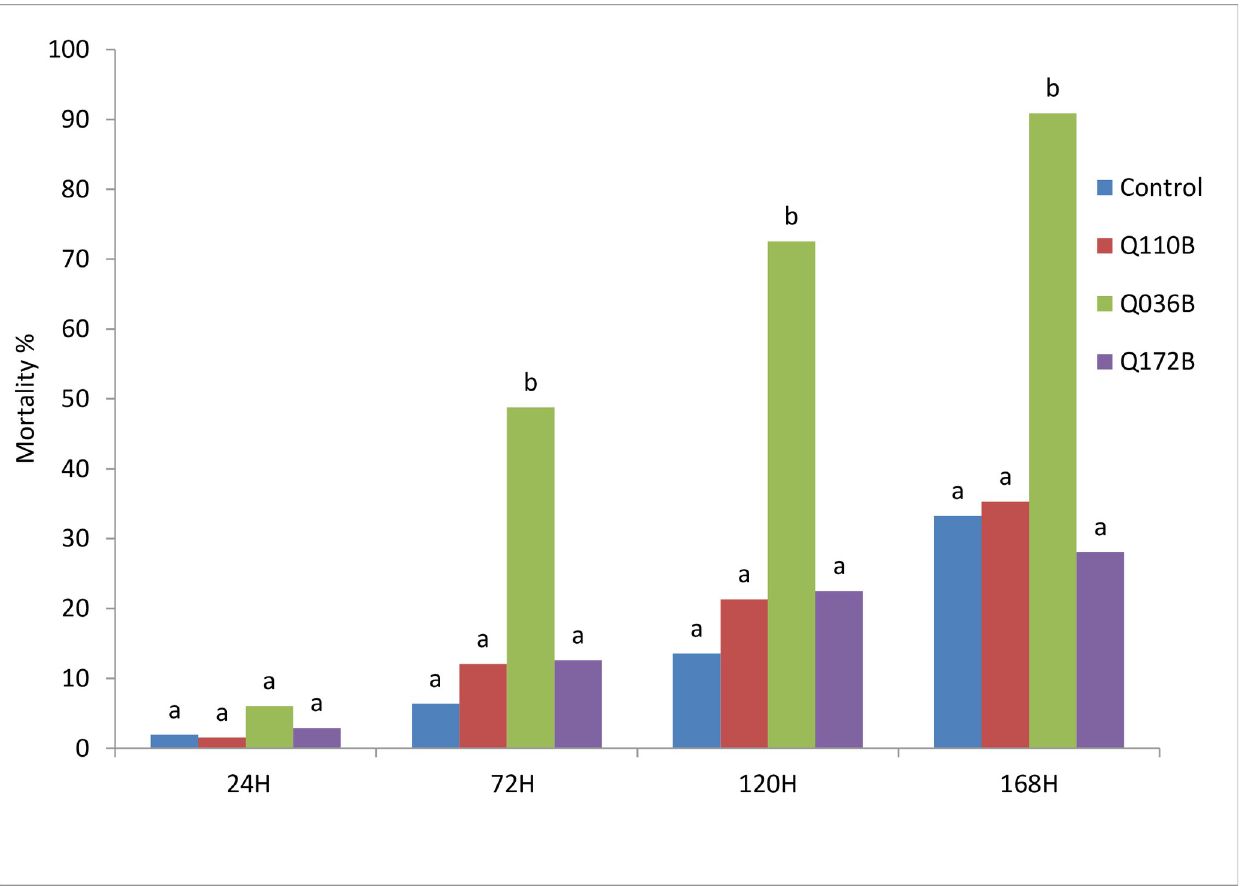
Fig 3. Influence of Pseudomonas isolate on mortalities rate of B . tabaci larvae over time under glasshouse conditions. Means with the same letter are not significantly different according to the Newman–Keuls multiple range test ( α = 0.01).